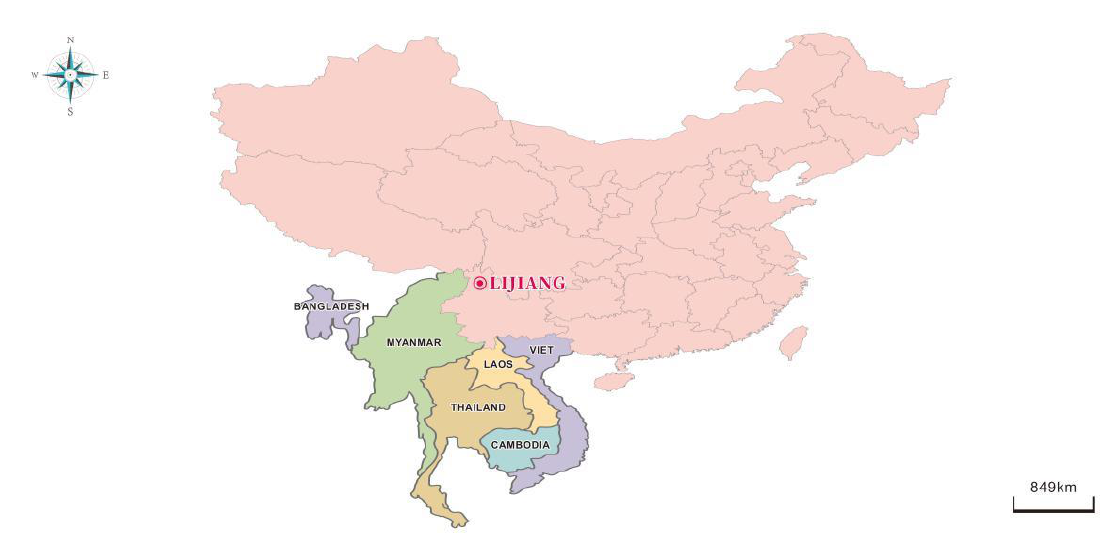
Figure 1. Map of sampling site.